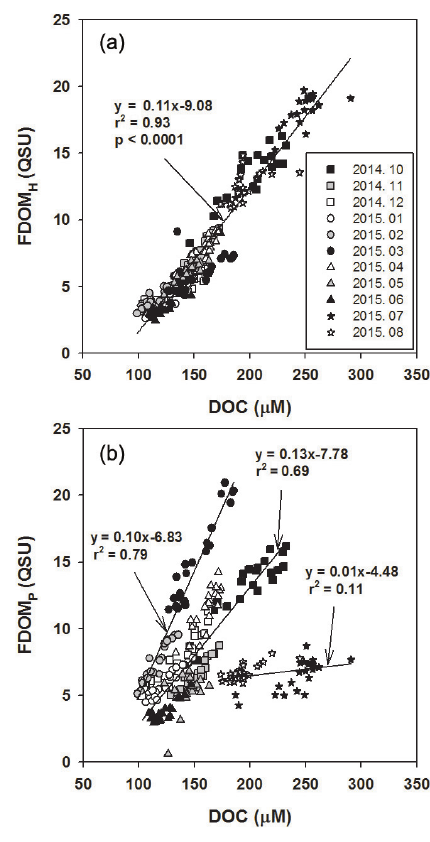
Figure 3. Plots of the concentrations of DOC versus the concentra- tions of (a) FDOM H and (b) FDOM P